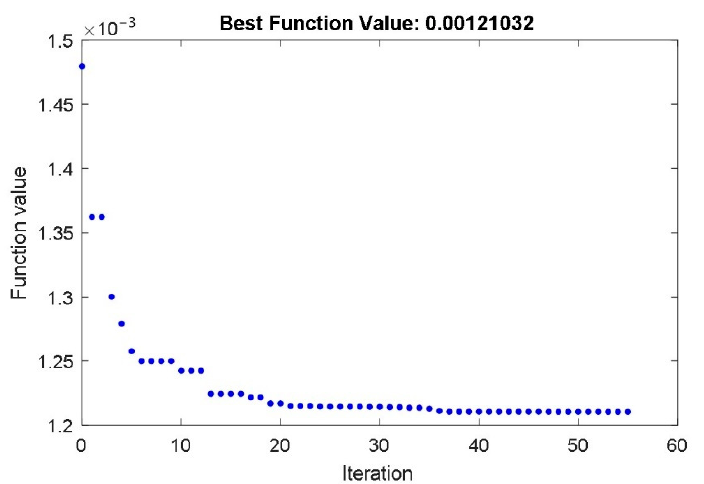
Figure 10. The time course of the IAE objective function during the PSO with the parameters μ m , P i , S m , S i , α and β S m , S i , α and β .